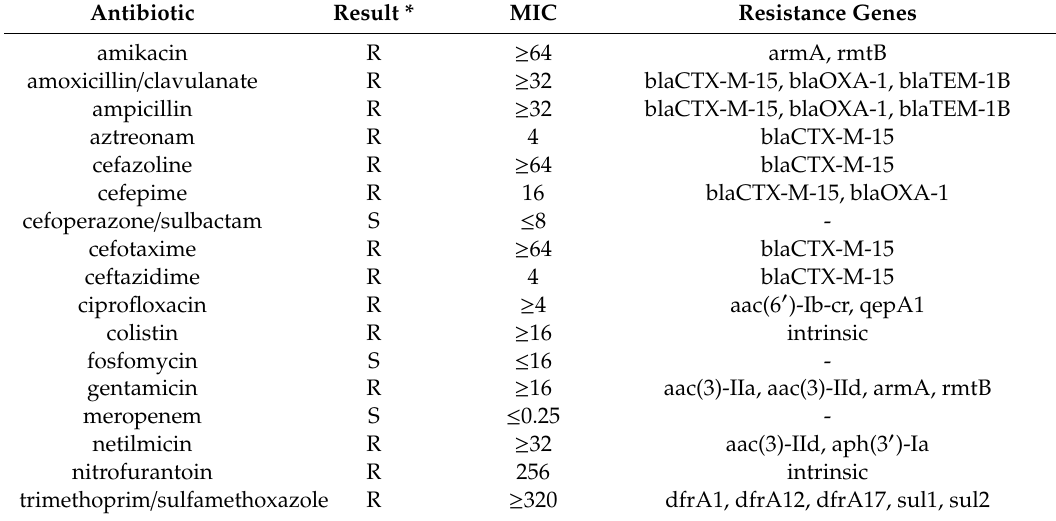
Table 1. Antibiotic resistance of CriePir89 and corresponding resistance